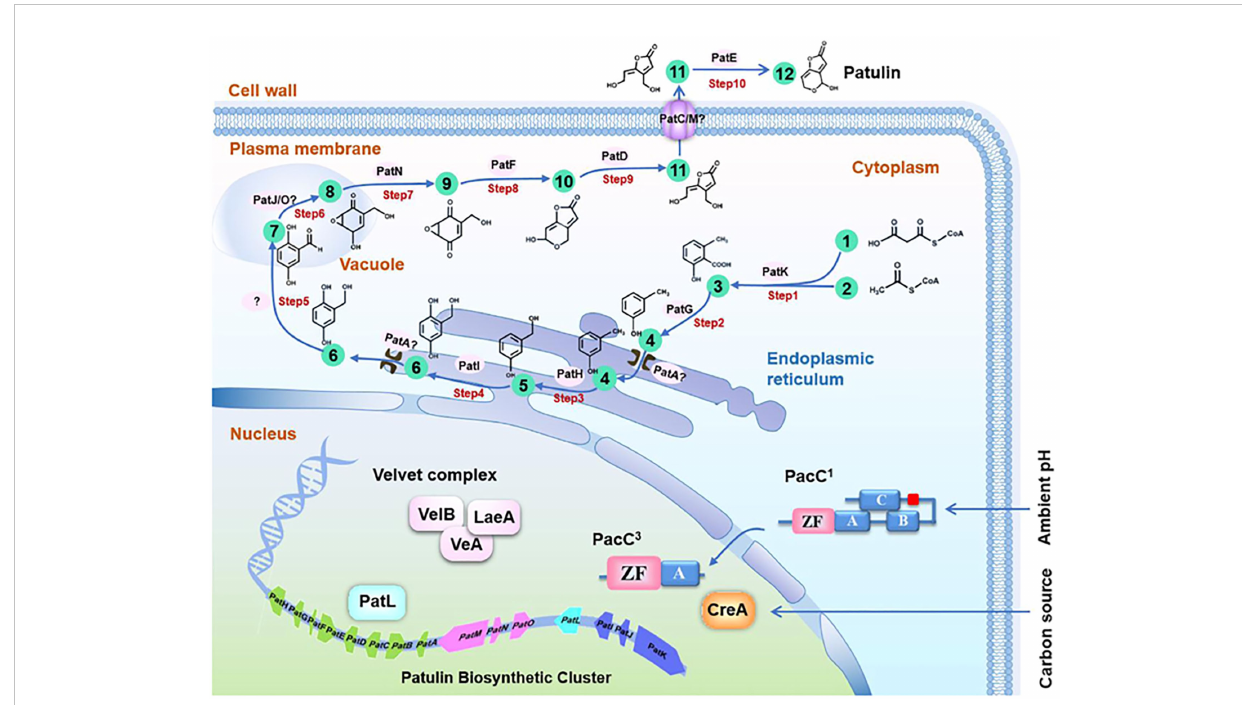
FIGURE 1 Molecular basis and regulation of the patulin biosynthetic pathway in Penicillium expansum . The patulin biosynthetic pathway consists of a 10-step reaction and 12 metabolites. 1, Acetyl CoA; 2, Malonyl CoA; 3: 6-Methylsalicylic acid; 4: m-Cresol; 5: m-Hydroxybenzyl alcohol; 6: Gentisyl alcohol; 7: Gentisaldehyde; 8: Isoepoxydon; 9: Phyllostine; 10: Neopatulin; 11: E-ascladiol; 12: Patulin. (Li et al.,